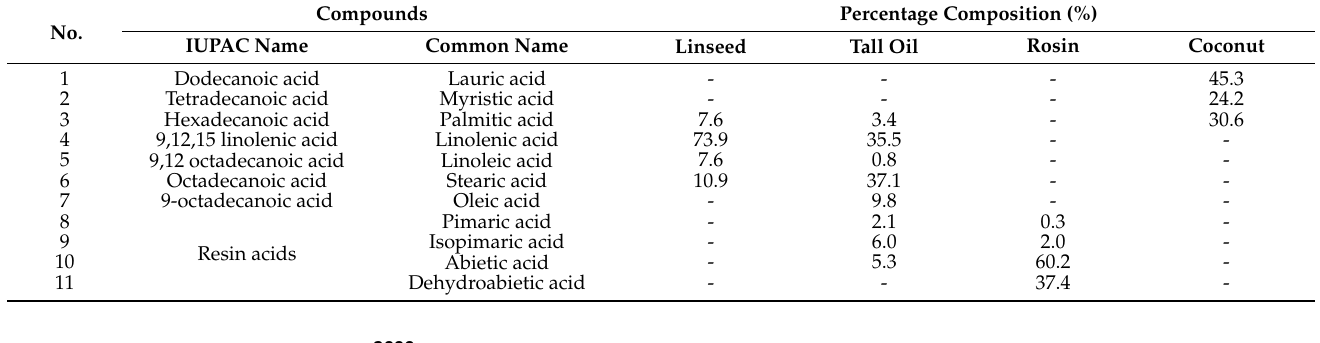
Table 2. Fatty and resin acids identified in the four additive oils by GC-MS. They are presented as a percentage of the total fatty and resin acids content for each of the additive oils.